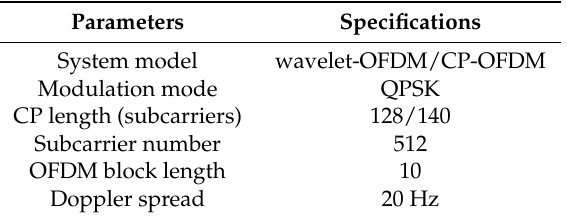
Table 2. Parameters for wavelet-OFDM and CP-OFDM